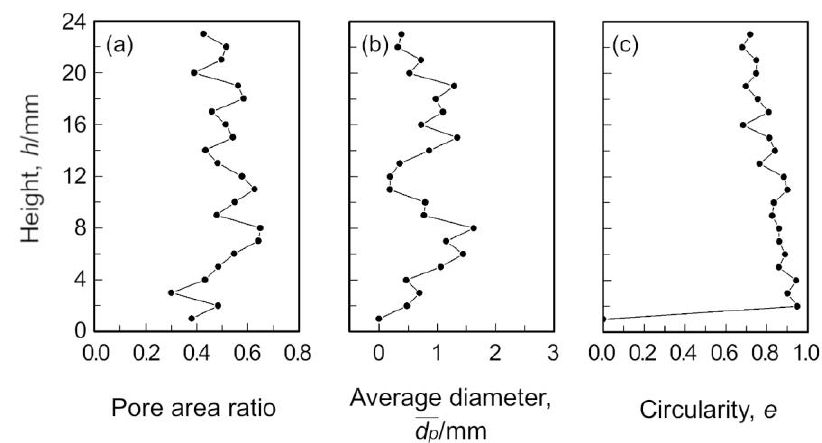
Figure 6. Distributions of the pore properties. ( a ) Distribution of the pore area ratio Σ A p / A , ( b ) distribution of the average pore diameter d p , ( c ) distribution of the pore circularity e .